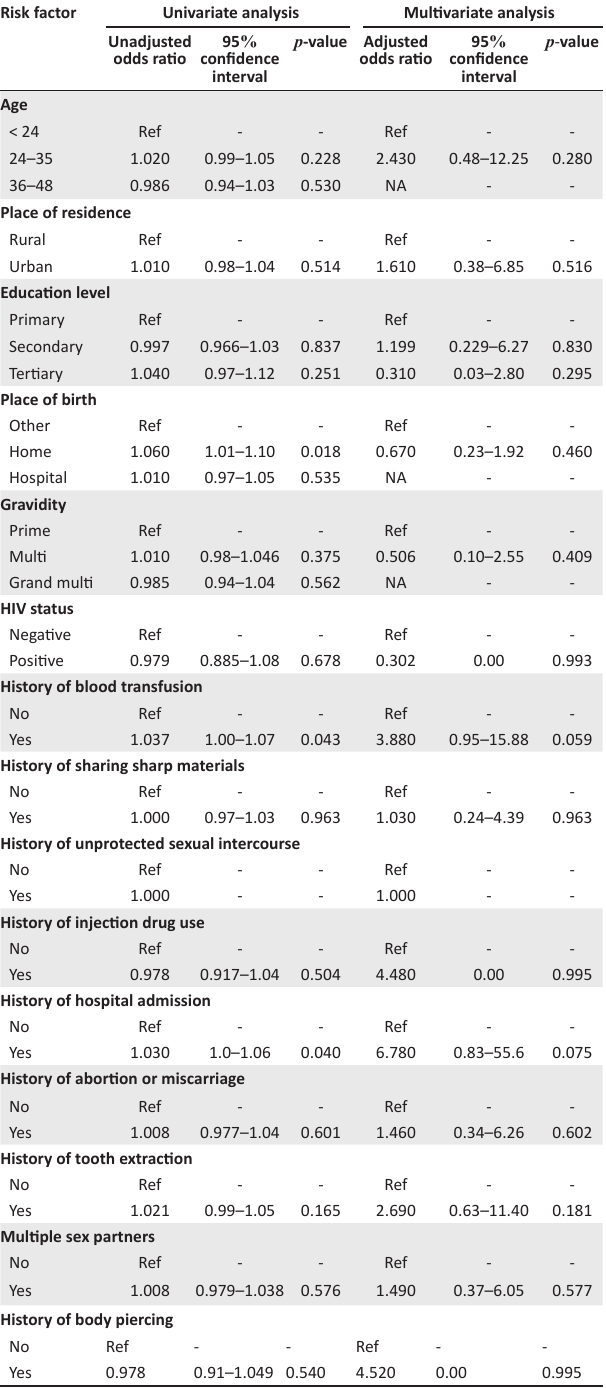
TABLE 4: Risk factors predisposing pregnant women to HBV at Kyazanga Health Centre IV, South Western Uganda, between April and June 2021. Risk factor Univariate analysis Multivariate analysis Unadjusted odds